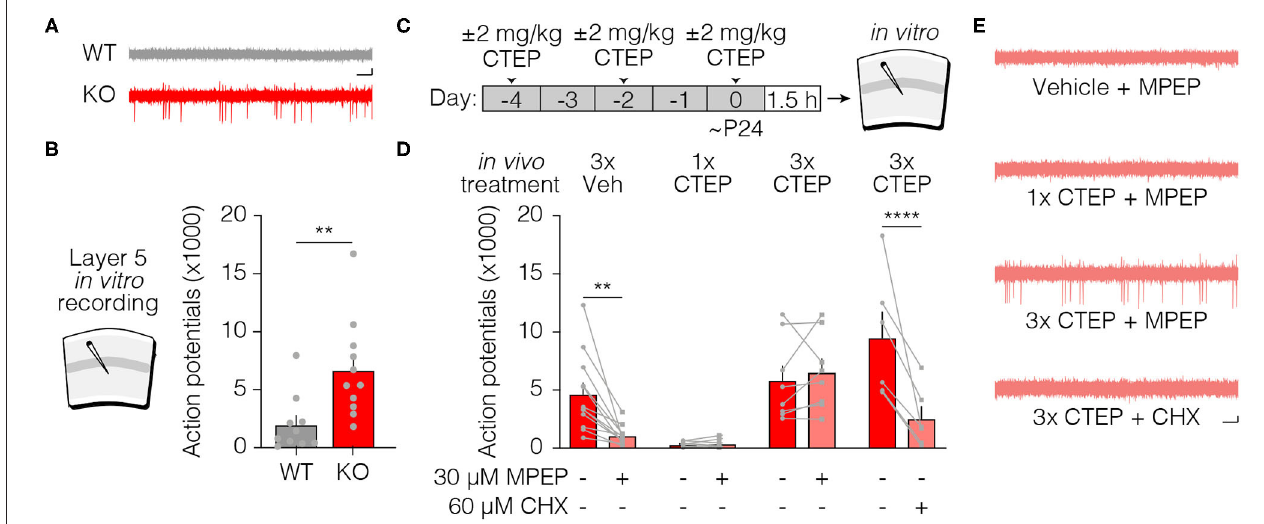
FIGURE 3 | Acute but not chronic CTEP treatment ameliorates hyperexcitability in Fmr1-KO layer 5 of primary visual cortex. (A) Representative traces of extracellular recordings in layer 5 of primary visual cortex from wild type (black) and Fmr1-KO (red) animals show increased spontaneous firing in Fmr1-KO slices (Scale bar represents 200 µ V by 200ms). (B) Layer 5 neurons in Fmr1-KO mice have significantly increased spontaneous action potentials compared to wild type littermates (paired t -test: wild type vs. Fmr1-KO: p = 0.0062). (C) Schematic shows acute and chronic CTEP dose schedules and visual cortical excitability experimental design. (D1) Elevated spontaneous activity in layer 5 primary visual cortical slices from Fmr1-KO mice is significantly reduced by bath application of 30 µ M MPEP (Two-tailed paired t -test: Fmr1-KO 3x vehicle + vehicle vs. Fmr1-KO 3x vehicle + MPEP: p = 0.0024) or (D2) an acute injection in vivo of 2 mg/kg CTEP (Two-tailed paired t -test: Fmr1-KO 1x CTEP + vehicle vs. Fmr1-KO 1x CTEP + MPEP: p = 0.1693). (D3) Chronic 2 mg/kg CTEP (3 doses over 5 days) leads to treatment resistance of spontaneous activity in layer 5 primary visual cortex that is not overcome by bath application of 30 µ M MPEP (Two-tailed paired t -test: Fmr1-KO 3x CTEP + vehicle vs. Fmr1-KO 3x CTEP + MPEP: p = 0.4327) but (D4) is significantly reduced by bath application of 60 µ M CHX (Two-tailed paired t -test: Fmr1-KO 3x CTEP + vehicle vs. Fmr1-KO 3x CTEP + CHX: p = 0.0102). (E) Representative traces of extracellular recordings in layer 5 primary visual cortex showing spontaneous activity in Fmr1-KO slices treated with bath applied 30 µ M MPEP, animals injected acutely with 2 mg/kg CTEP, and animals injected chronically (3 doses over 5 days) with 2 mg/kg CTEP followed by bath application of either 30 µ M MPEP or 60 µ M CHX (Scale bar represents 200 µ V by 200ms). Data are displayed as mean ± SEM. ** p < 0.01, **** p <